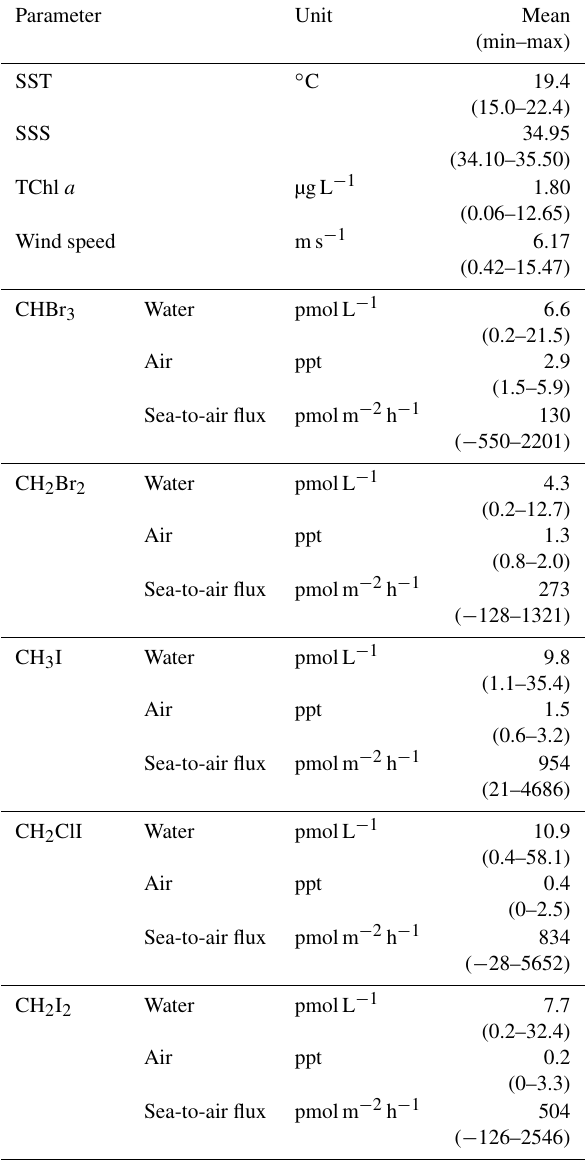
Table 1. Environmental parameters, as well as halocarbons in wa- ter, air and sea-to-air fluxes during the cruise. Means of sea surface temperature (SST), sea surface salinity (SSS) and wind speed are for 10min averages. All data can be accessed at PANGAEA (Hep- ach et al.,